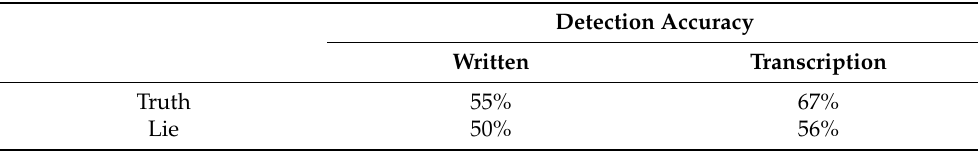
Table 2. Average accuracy of truth and lie